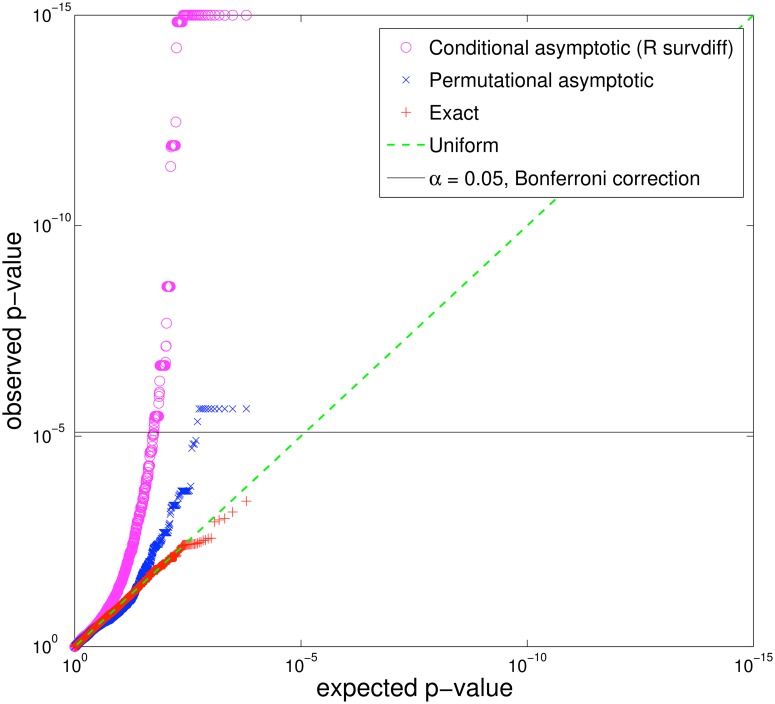
Differences between observed and expected p-values from different forms of the log-rank test on a randomized cancer dataset consisting of somatic mutations in 6184 genes.The p-values for the genes should be distributed uniformly (green line), since there is no association between mutations and survival in this random data. Asymptotic approximations of the log-rank statistic (purple and blue) yield p-values that deviate significantly from the uniform distribution, incorrectly reporting many genes whose mutations are significantly associated with survival. In particular, the asymptotic log-rank test in R reports 110 genes with significant association, using a Bonferroni corrected p-value < 0.05 (black line), or 291 genes with significant association using a less conservative FDR = 0.05. In contrast, the exact test makes no false discoveries.